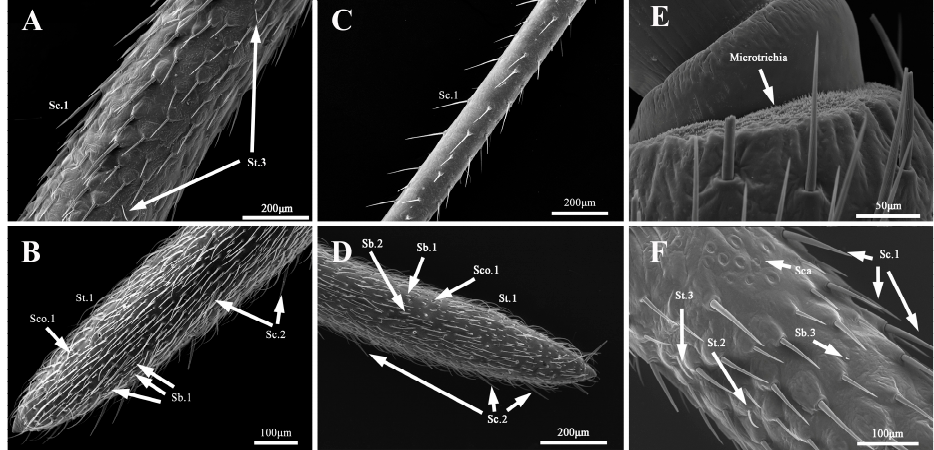
Figure 4. N. meleagris ( A ) Scape, pedicel, and fi rst fl agellomere of adult; ( B ) second fl agellomere of adult; ( C ) scape, pedicel and fi rst fl agellomere of nymph; ( D ) second fl agellomere of nymph; ( E ) microtrichia; ( F ) base of the scape of antennae of adult. 3.2. Types and Distribution of Sensilla in the Nymphal Instars The antennae of each nymphal instar were observed via SEM, which revealed four types of sensilla: sensilla trichodea (St), sensilla basiconica (Sb), sensilla chaetica (Sc), and sensilla coeloconica (Sco). Based on the di ff erences in size and external morphological characteristics, St was divided into three subtypes (St.1, St.2, and St.3), Sb was divided into two subtypes (Sb.1 and Sb.2), and Sc was divided into two subtypes (Sc.1 and Sc.2). Each sensillum showed various distributions among the nymphal instars. 3.2.1. Sensilla Trichodea Among the three St subtypes, St.1 was the most abundant on the antennal surface in each nymphal instar and was distributed in the second fl agellomere. The number of St.1 on the antennae of the fi rst to fi fth nymphal instars was 231.0–1226.3 (Table 1). They are long, thin hairs that are curved with a smooth surface and a rounded tip with a fl exible socket. (Figure 5). The length and base diameter of St.1 in the fi rst to fi fth nymphal instars were 30.443–59.548 and 1.362–3.184 µm, respectively. The length of St.1 in the fi fth and fourth nymphal instars was signi fi cantly greater than that in the third and second nym- phal instars. The length of St.1 in the third and second nymphal instars was signi fi cantly greater than that in the fi rst nymphal instar. The diameter of St.1 in the fi fth nymphal instar did not di ff er signi fi cantly from that in the fourth nymphal instar. The diameter of St.1 in the fourth nymphal instar did not di ff er signi fi cantly from that in the third and below nymphal instars. However, the diameter of St.1 in the fi fth nymphal instar was sig- ni fi cantly greater than that in the third and below nymphal instars (Table S2). Among the three St subtypes, St.2 had the shortest length and was distributed vertically in the scape, pedicel, and fi rst fl agellomere of the fourth and fi fth nymphal instars. The number of St.2 on the fourth and fi fth nymphal instar antennae was 2.0–4.9 (Table 1). They are short and slightly curved, with smooth surfaces and a rounded tip, and a fl exible socket. (Figure 5). The length and basal diameter of St.2 in the fourth and fi fth nymphal instars were 27.148– 41.575 and 2.770–4.526 µm, respectively. The length of St.2 in the fi fth nymphal instar was signi fi cantly greater than that in the fourth nymphal instar, whereas no signi fi cant di ff er- ence was observed in the diameter of St.2 in these nymphal instars (Table S2). St.3 was distributed vertically in the scape, pedicel, and fi rst fl agellomere of the fourth and fi fth nymphal instars. The number of St.3 on the antennae of the fourth and fi fth nymphal